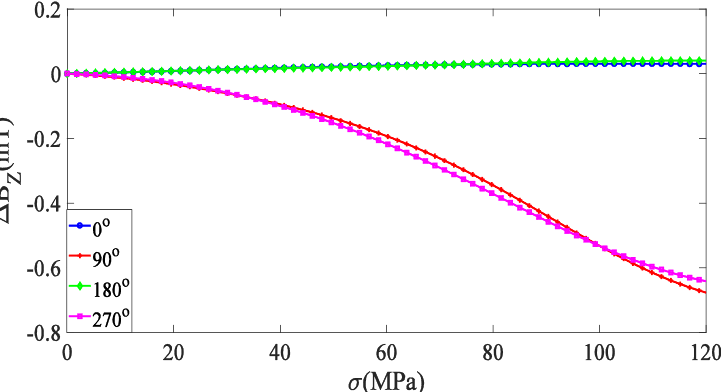
Figure 8. Variations of B Z relative to stress σ at angles of 0°, 90°, 180°, and 270°, after eliminating the influence of the initial field.